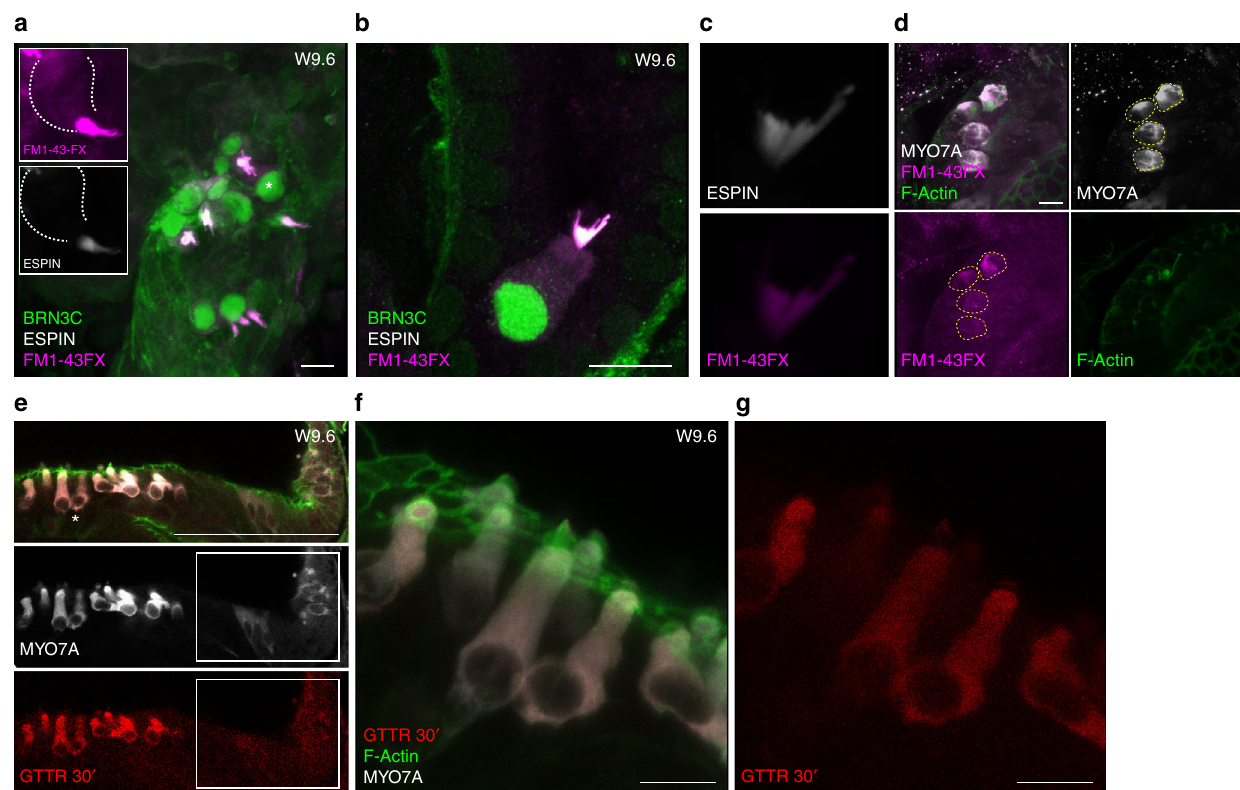
Fig. 7 Functional characterization of the in vitro-derived hair cell-like cells. a Organoid derived from a W9.6 sample (E1286), stained for ESPIN and BRN3C after FM1 – 43 labeling. Scale bar 10 μ m. The same cell marked by the asterisk is shown in the inserts. b Hair cell-like cell stained for ESPIN and BRN3C after FM1 – 43 labeling. Scale bar 10 μ m. Gain values for FM1 – 43 are set in order to visualize intracellular dye loading. c Re-image with lower gain of ESPIN + bundle and FM1 – 43. d Hair cell -like cells derived from a EPCAM + /CD271 + organoid from a W12 sample (E1289) stained for MYO7A and F-actin after FM1 – 43 loading. Cell volumes de fi ned in the MYO7A channel (dashed lines) were used to assess fl uorescence intensity in the FM1 – 43 channel as shown in Supplementary Fig. 9. Scale bar 10 μ m. For all examples ( a – d ) FM1 – 43 uptake was performed with a 30 s exposure in presence of concanavalin A. e Hair cell-like cells in an organoid derived from an EPCAM + /CD271 + sample (W9.6, E1286) showing GTTR uptake. The sample was incubated for 30 min with GTTR, followed by fi xation and immunostaining for MYO7A and staining with phalloidin to visualize bundles. 3D projection of a confocal stack is shown for the single channel and merged colors. Boxed area indicates developing MYO7A positive cells. Scale bar = 100 μ m. f 3D reconstruction of the area marked in e by the asterisks. Merged image f and red channel g are shown. Scale bar 10 μ